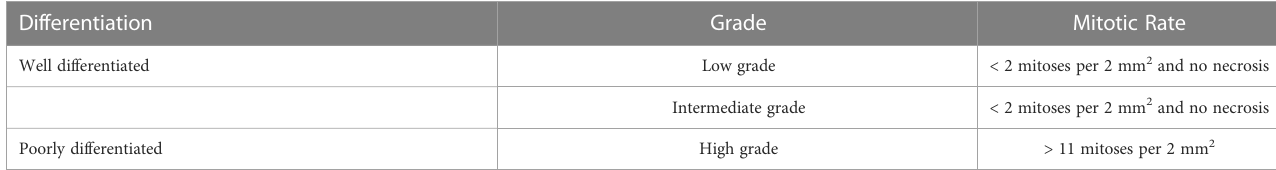
TABLE 1 2015 WHO classi fi cation of lung NENs 3 . Differentiation Grade Mitotic Rate Well